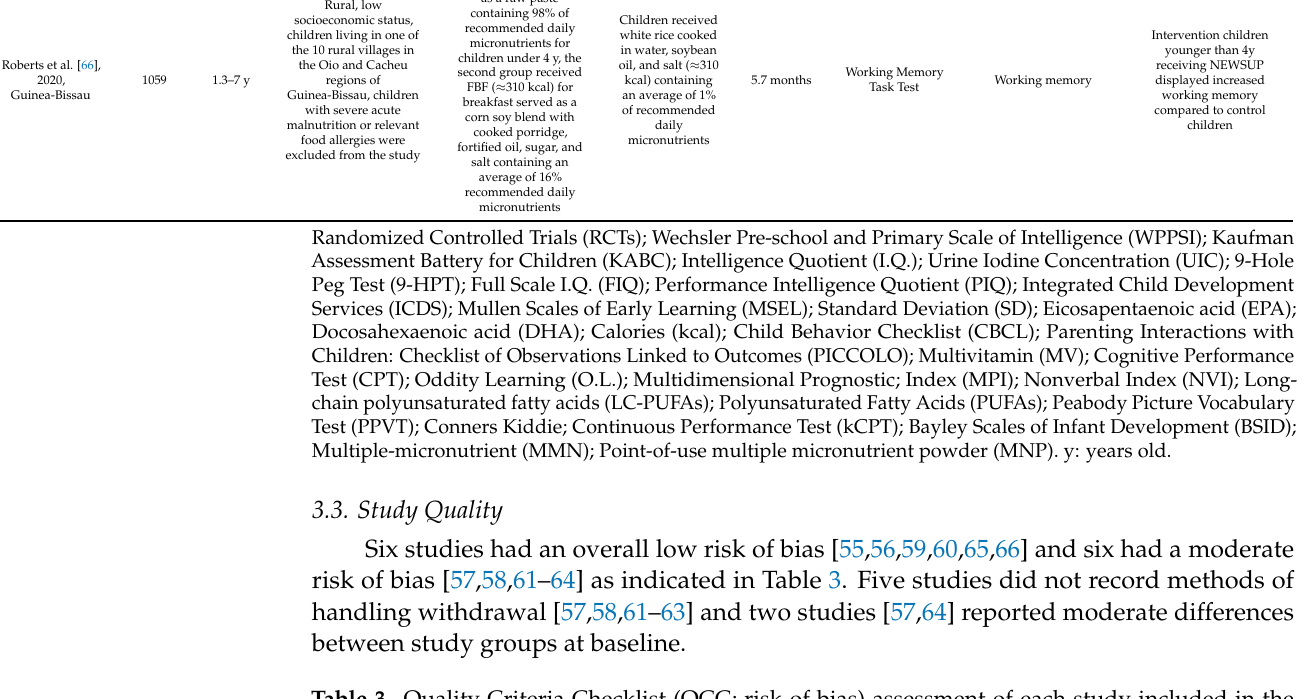
Table 3. Quality Criteria Checklist (QCC; risk of bias) assessment of each study included in the review